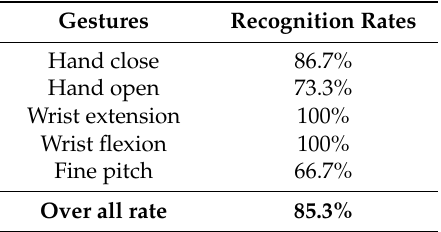
Table 2. Recognition rates on unsegmented hand images.